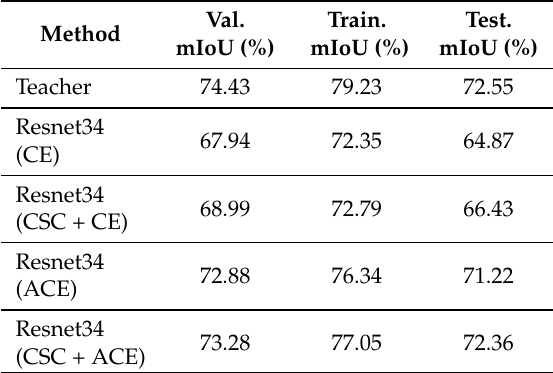
Table 1. Effects of different components of the loss in the proposed loss function. CSC is the channel and spatial correlation loss, ACE is the adaptive cross-entropy loss, and CE is the conventional cross-entropy loss. Our experiments were initialized from pretrained weights on ImageNet.